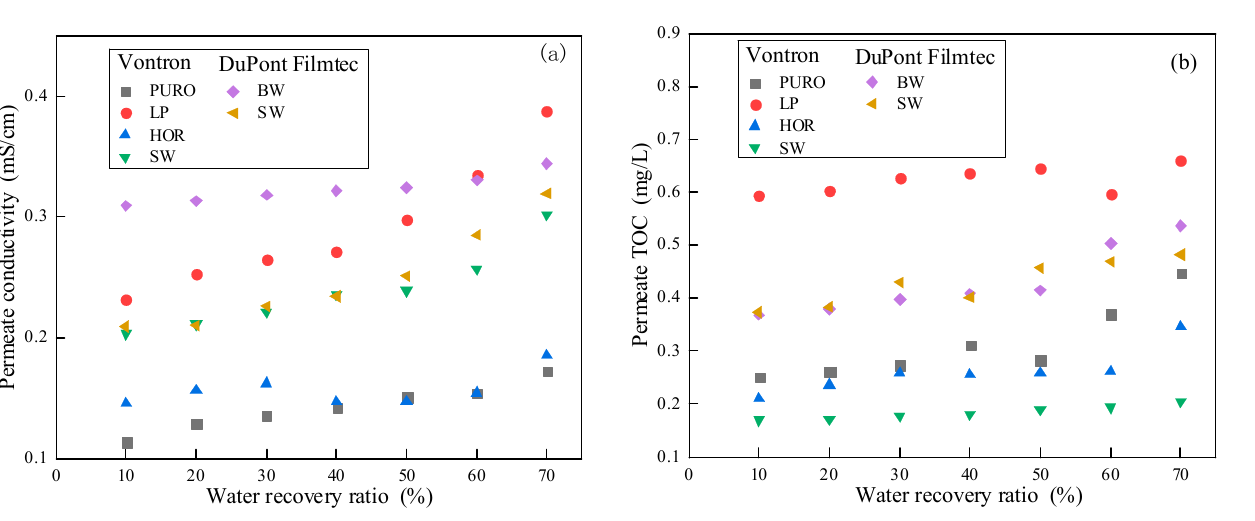
Figure 2. Changes in permeate conductivity ( a ) and TOC ( b ) of each RO membrane with water recovery ratio. Table 3. Permeate quality of each RO membrane at water recovery ratio of 70%.